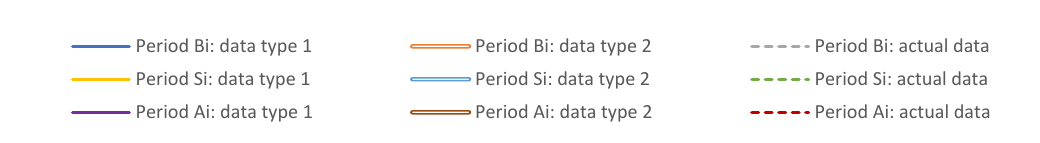
Figure 6. The incoming calls based on the two data types and actual data.